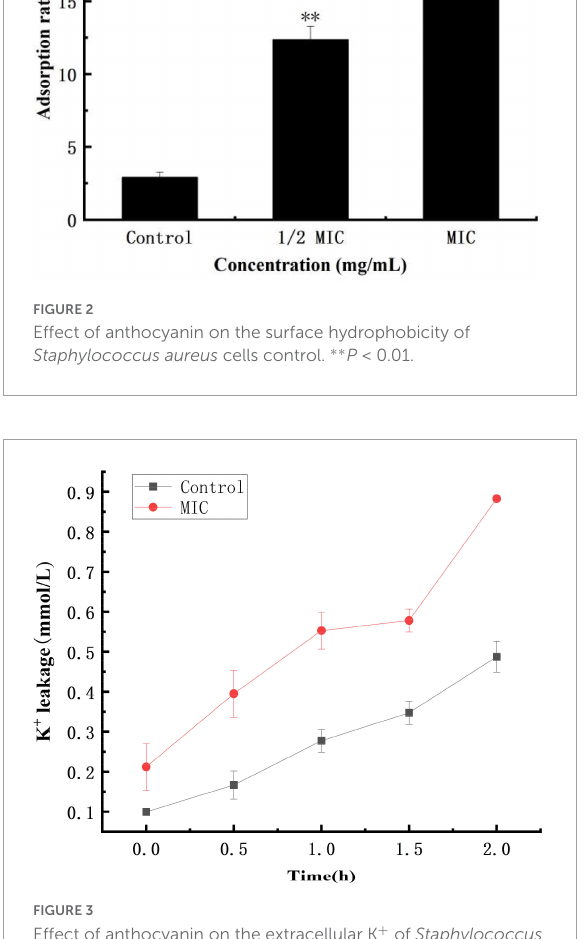
FIGURE5 SDS-PAGE images of